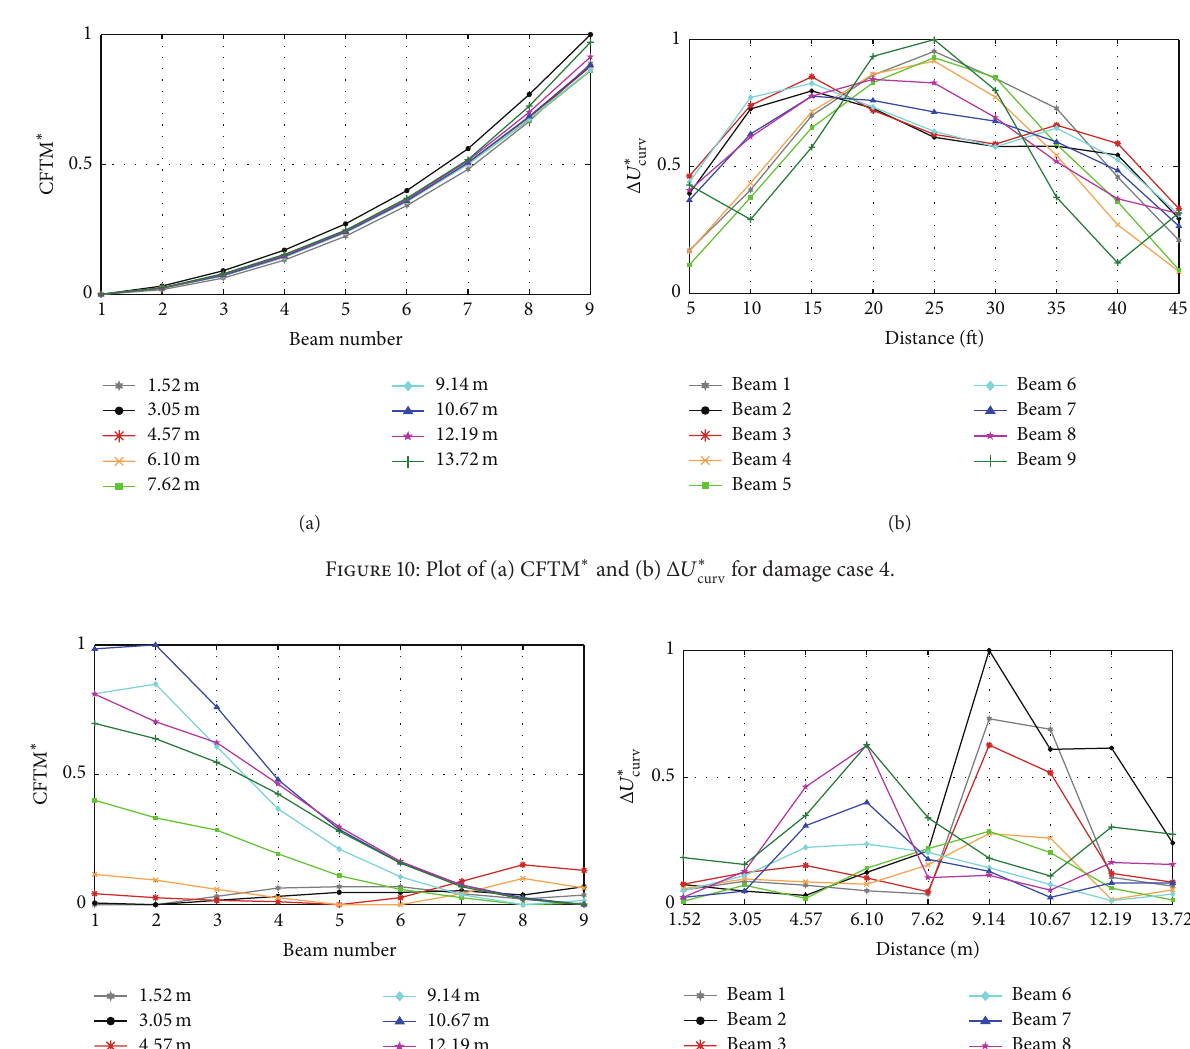
Figure 11: Plot of (a) CFTM ∗ and (b) Δ𝑈 ∗